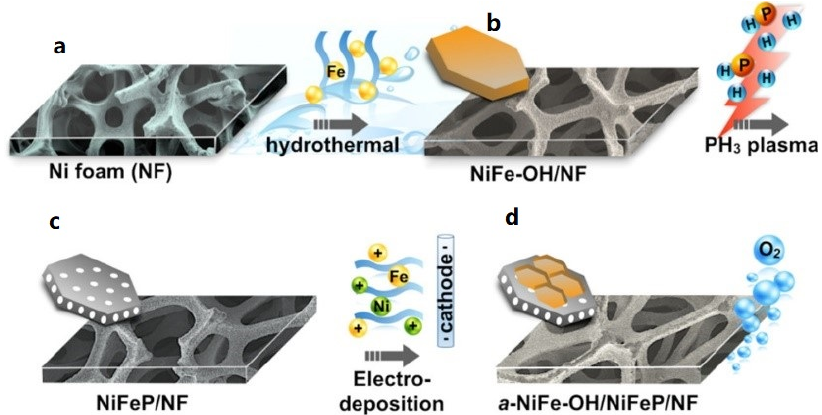
Figure 24. Plasma-assisted strategy to hierarchical α -NiFe-OH/NiFeP/NF electrocatalysts for water oxidation: ( a ) Ni foam substrate, ( b ) NiFe-DH nanoplates hydrothermally grown on Ni foam, ( c ) conversion of NiFe-DH to porous NiFeP nanoplates, using PH 3 plasma, and ( d ) electrodeposition of amorphous NiFe-OH nanosheet layer onto NiFeP. Reproduced from [85], with permission from John Wiley and Sons, copyright